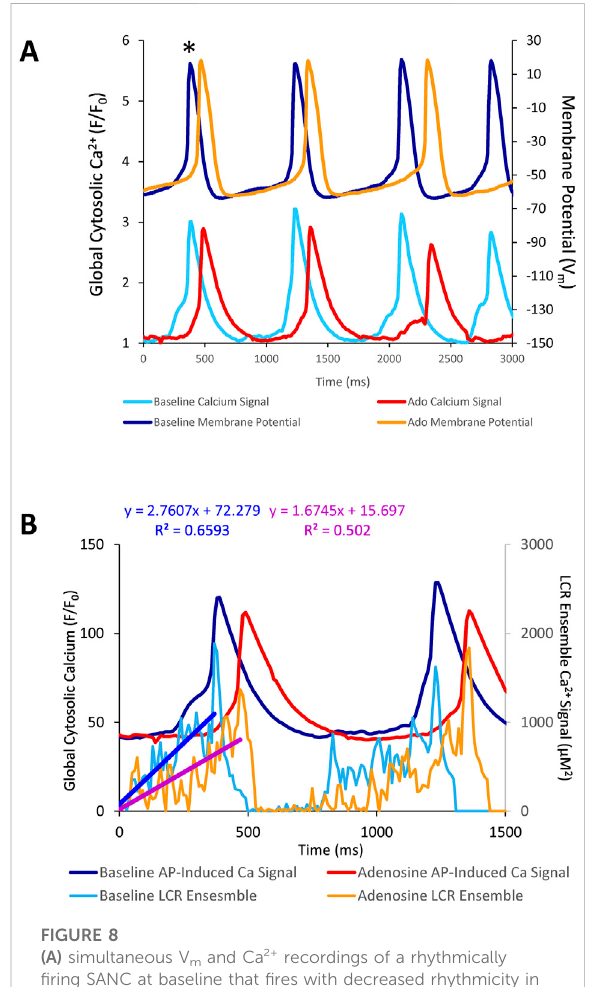
FIGURE 8 (A) simultaneous V m and Ca 2+ recordings of a rhythmically fi ring SANC at baseline that fi res with decreased rhythmicity in response to 10 µM Ado. (B) the rate of LCR ensemble growth is steeper at baseline (blue line) and decreases in response to adenosine (magenta line). The asterisk indicates the baseline and ado cycle lengths measured in Figure 8A.